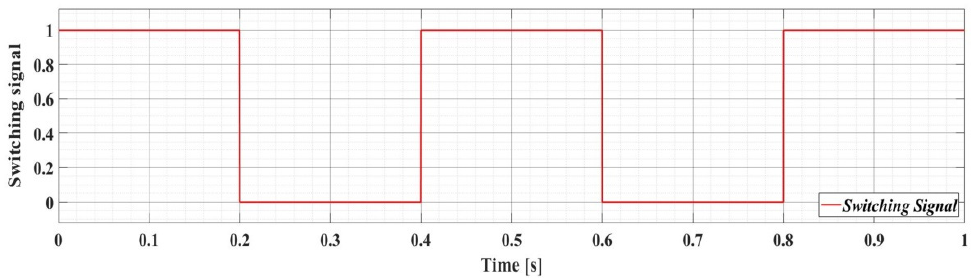
Figure 11. Switching signal type 1.